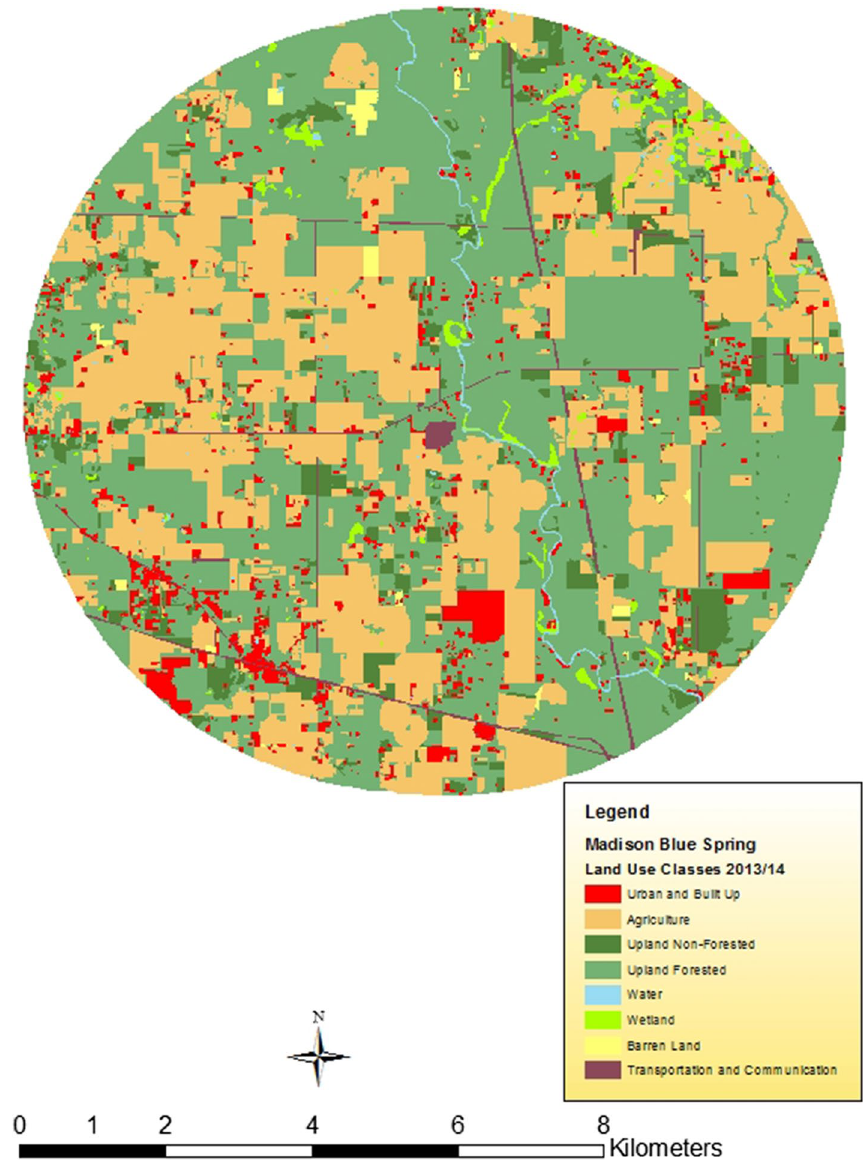
Fig. 5 Land use within 10 km of Madison Blue cave passage centerline